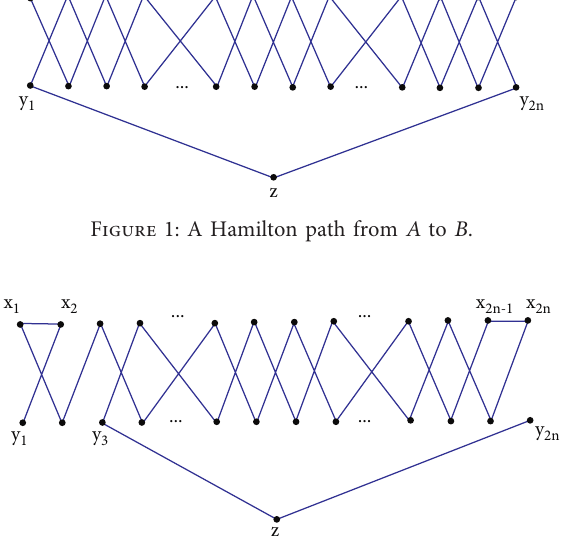
Figure 2: A Hamilton path from A to B